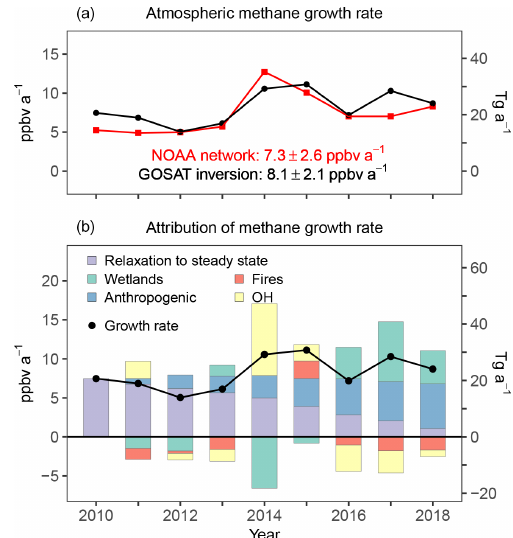
Figure 14. The 2010–2018 annual growth rates in global atmo- spheric methane. (a) Comparison of annual growth rates inferred from our inversion of GOSAT data and from the NOAA surface network (Dlugokencky, 2020). Average methane growth rates for the period are inset. (b) Attribution of annual growth rates in the GOSAT inversion to perturbations of emissions (anthropogenic, wetlands, fires) and OH concentrations relative to 2010 conditions. The purple bar shows the relaxation of the 2010 budget imbalance to steady state. See the text for details explaining the breakdown.